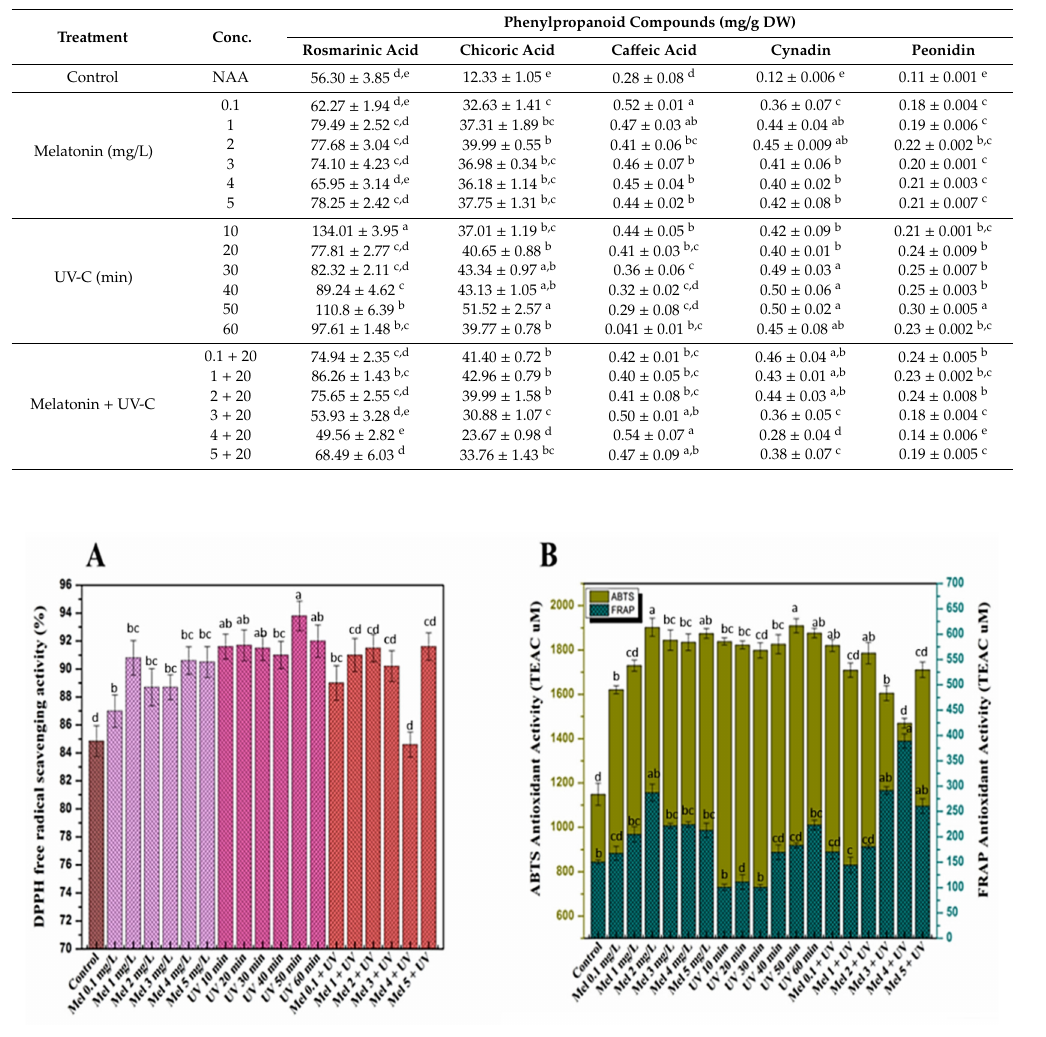
Figure 3. ( A ) % free radical scavenging and ( B ) antioxidant activities (ABTS and FRAP (TEAC µ M)) in purple basil calli in response to di ff erent treatments of UV-C, melatonin and Mel + UV-C. Values are means ± SE from triplicates. Columns with similar alphabets are not significantly di ff erent ( p < 0.05) according to Tukey’s